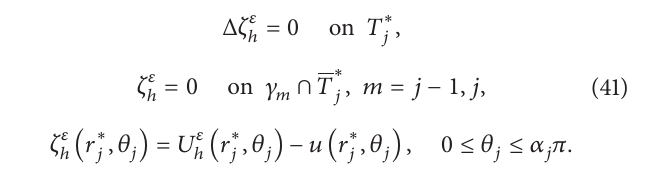
Table 5: In 𝐺 𝑆 , the minimum errors of the derivatives over the pairs (ℎ −1 , 𝑛) in maximum norm when 𝜀 = 5 × 10 −13 . (ℎ −1